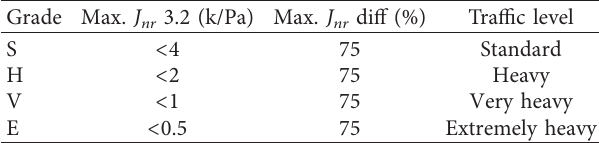
Figure 8: (a) Nonrecoverable creep compliance ( J nr ). (b) Percent recoverable silicone warm mix asphalt. Table 5: Definition of traffic level on the MSCR parameters